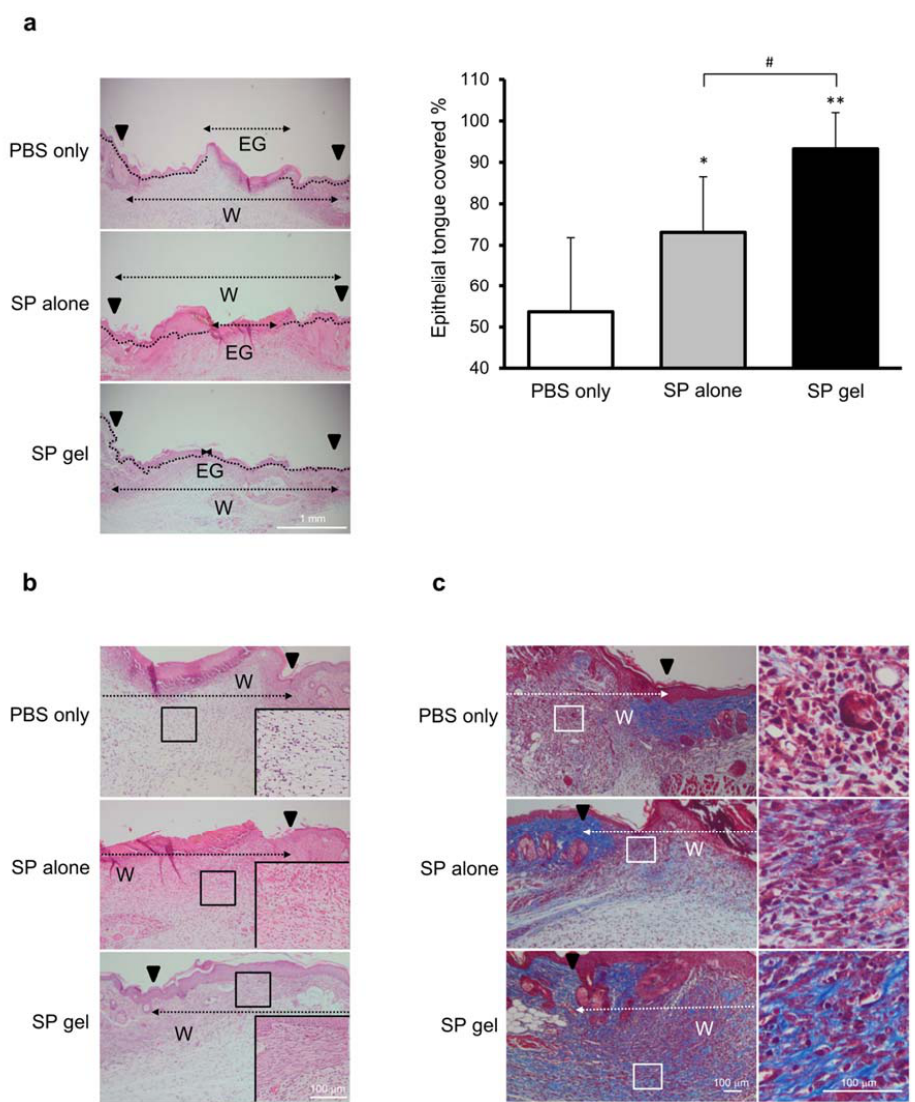
Figure 6. Histological analysis of SP gel ‐ treated wounds. ( a ) Quantification of epithelial tongue coverage. The wound edge (W) is indicated by a black arrowhead in histological sections. The epithelial gap (EG), which is the distance between the edges of the epithelium, is indicated by a black dotted line. Values represent mean ± SD ( n = 13 for PBS alone, n = 8 for SP alone, and n = 5 for SP gel). * p < 0.05, ** p < 0.01 vs. PBS ‐ only negative control; # p < 0.05 vs. SP alone. ( b , c ) Granulation tissue formation and collagen synthesis induced by treatment with SP gel. Histological sections of wounds were stained with H&E ( b ) or Masson’s trichrome ( c ) on day 6. Higher magnifications are shown in the inset in the lower right corner ( b ) and in panels to the right ( c ).